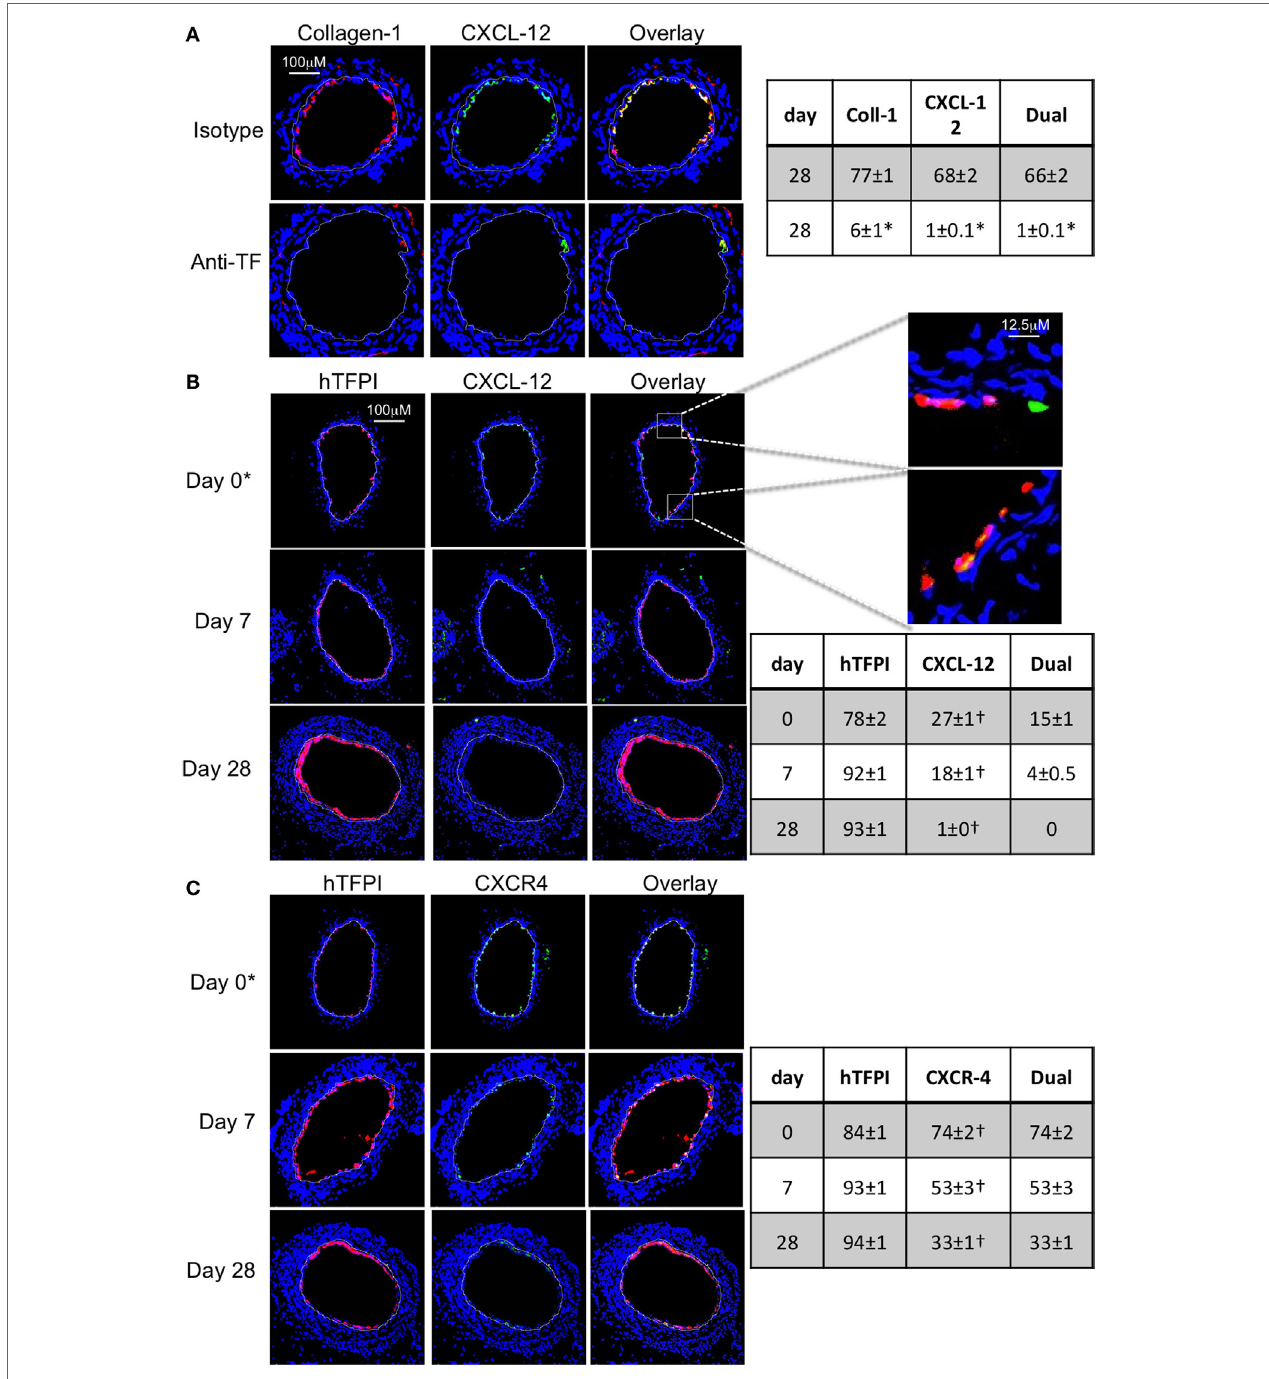
FigUre 10 | Recruitment after adoptive transfer with inhibition of tissue factor (TF). Panels show immunohistology of representative sections through injured mouse carotid arteries harvested on days post-injury as indicated. Sections from same day are consecutive. All sections stained with DAPI (4,6 diamidino-2-phenylindole) nuclear stain (blue) and (red) anti-collagen-1 (a) or human tissue factor pathway inhibitor (hTFPI) (B,c) , and (green) anti-CXCL-12 (a,B) or CXCR4 (c) . Yellow indicates co-localization. The annotated white line defines the junction between neointima and media. (a) Day 28 sections, in wild-type (WT) mice adoptively transferred CD34 + cells pre-incubated with istotype control or anti-TF antibody. (B,c) Adoptive transfer of purified CD31 + myofibrocytes from CD31-TFI-Tg mice to WT mice immediately post-injury. *Sections harvested within an hour of injury. Expanded areas illustrate that some of the early luminal CXCL-12 staining is independent of recruited hTFPI + cells. Table besides (a) describes summary of staining from all mice ( n = 6), showing the proportion of the neointimal area that is positive for collagen-1, CXCL-12, or both on day 28 (% ± SEM), whereas those besides (B,c) described proportion that is positive for hTFPI, CXCL-12 (B) , CXCR4 (c) , or dual positive on days 0, 7, and 28. Data derived from three random sections from each of the arteries from each mouse (see Materials and Methods). *cf isotype for anti-TF p < 0.001. † cf adoptive transfer of WT cells ( Figures 9B,c ) at equivalent times p < 0.001. Experiments repeated at least